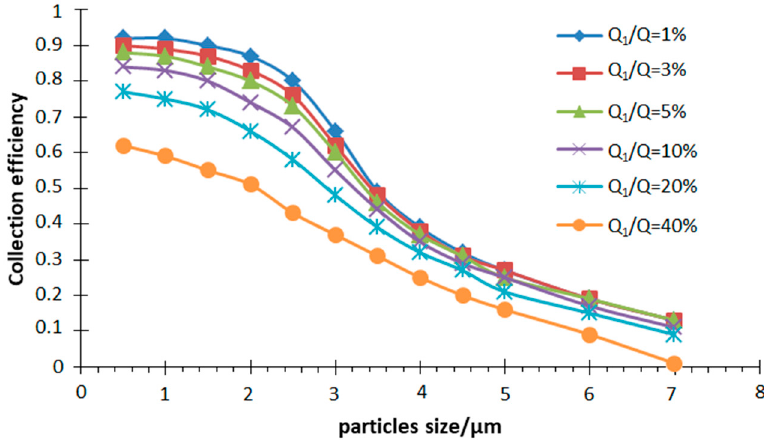
Figure 7. Collection efficiency curves at different split ratios ( Q 1 / Q ).